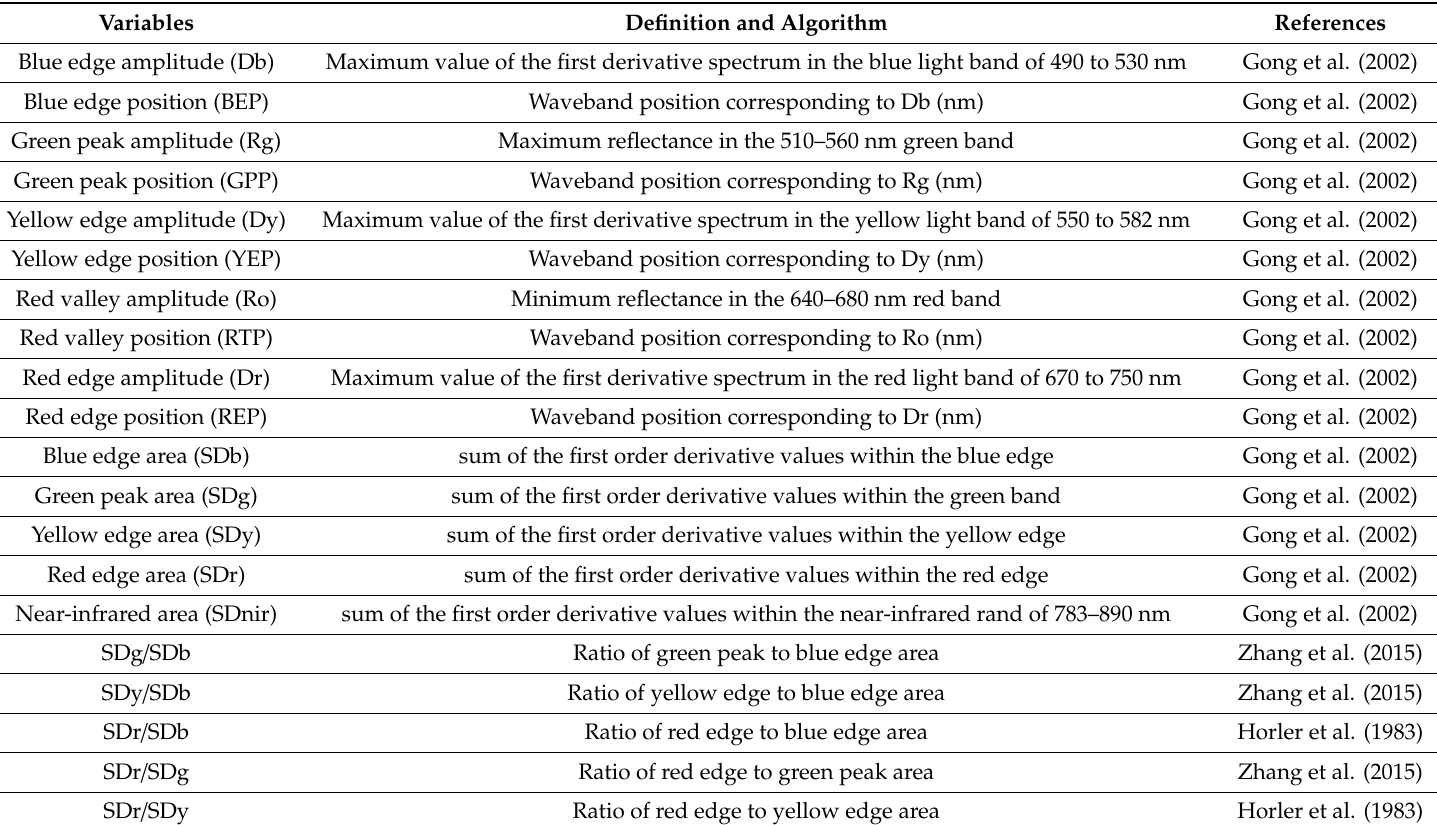
Table A1. Types of “three-edge”